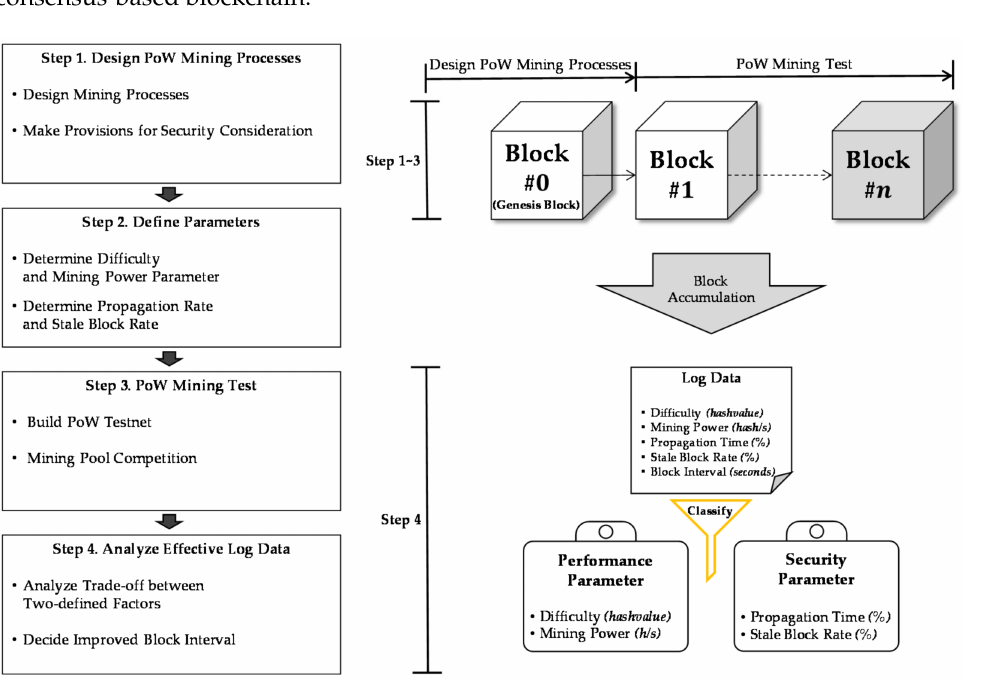
Figure 1. Process Overview of Adjusting Block Interval in PoW